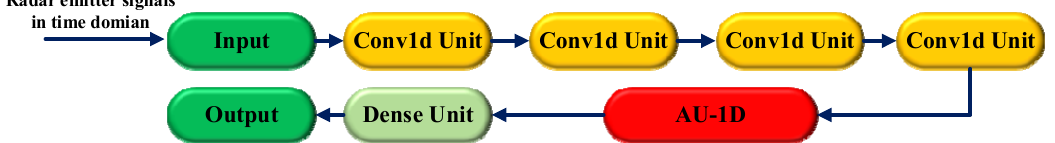
Figure 2. The structure of one-dimensional convolutional neural network with an attention mechanism (CNN-1D-AM).